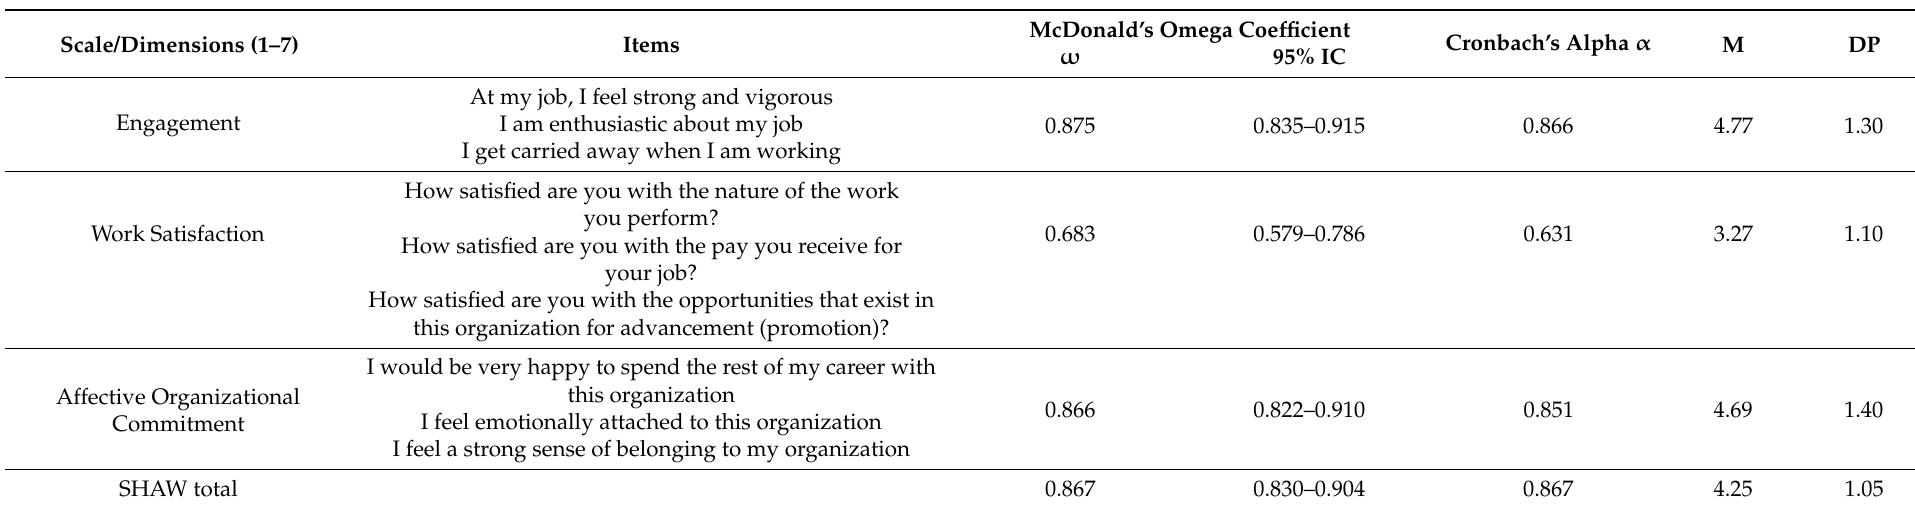
Table 2. McDonald’s, Cronbach’s Alpha, mean, standard deviation, SHAW’s items, and